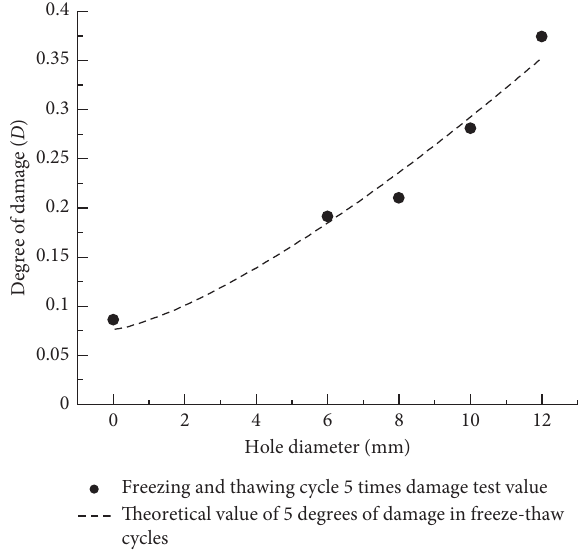
Figure 15: Damage curves of different diameter yellow sandstones (5 freeze-thaw cycles). Table 4: Fitting curve related